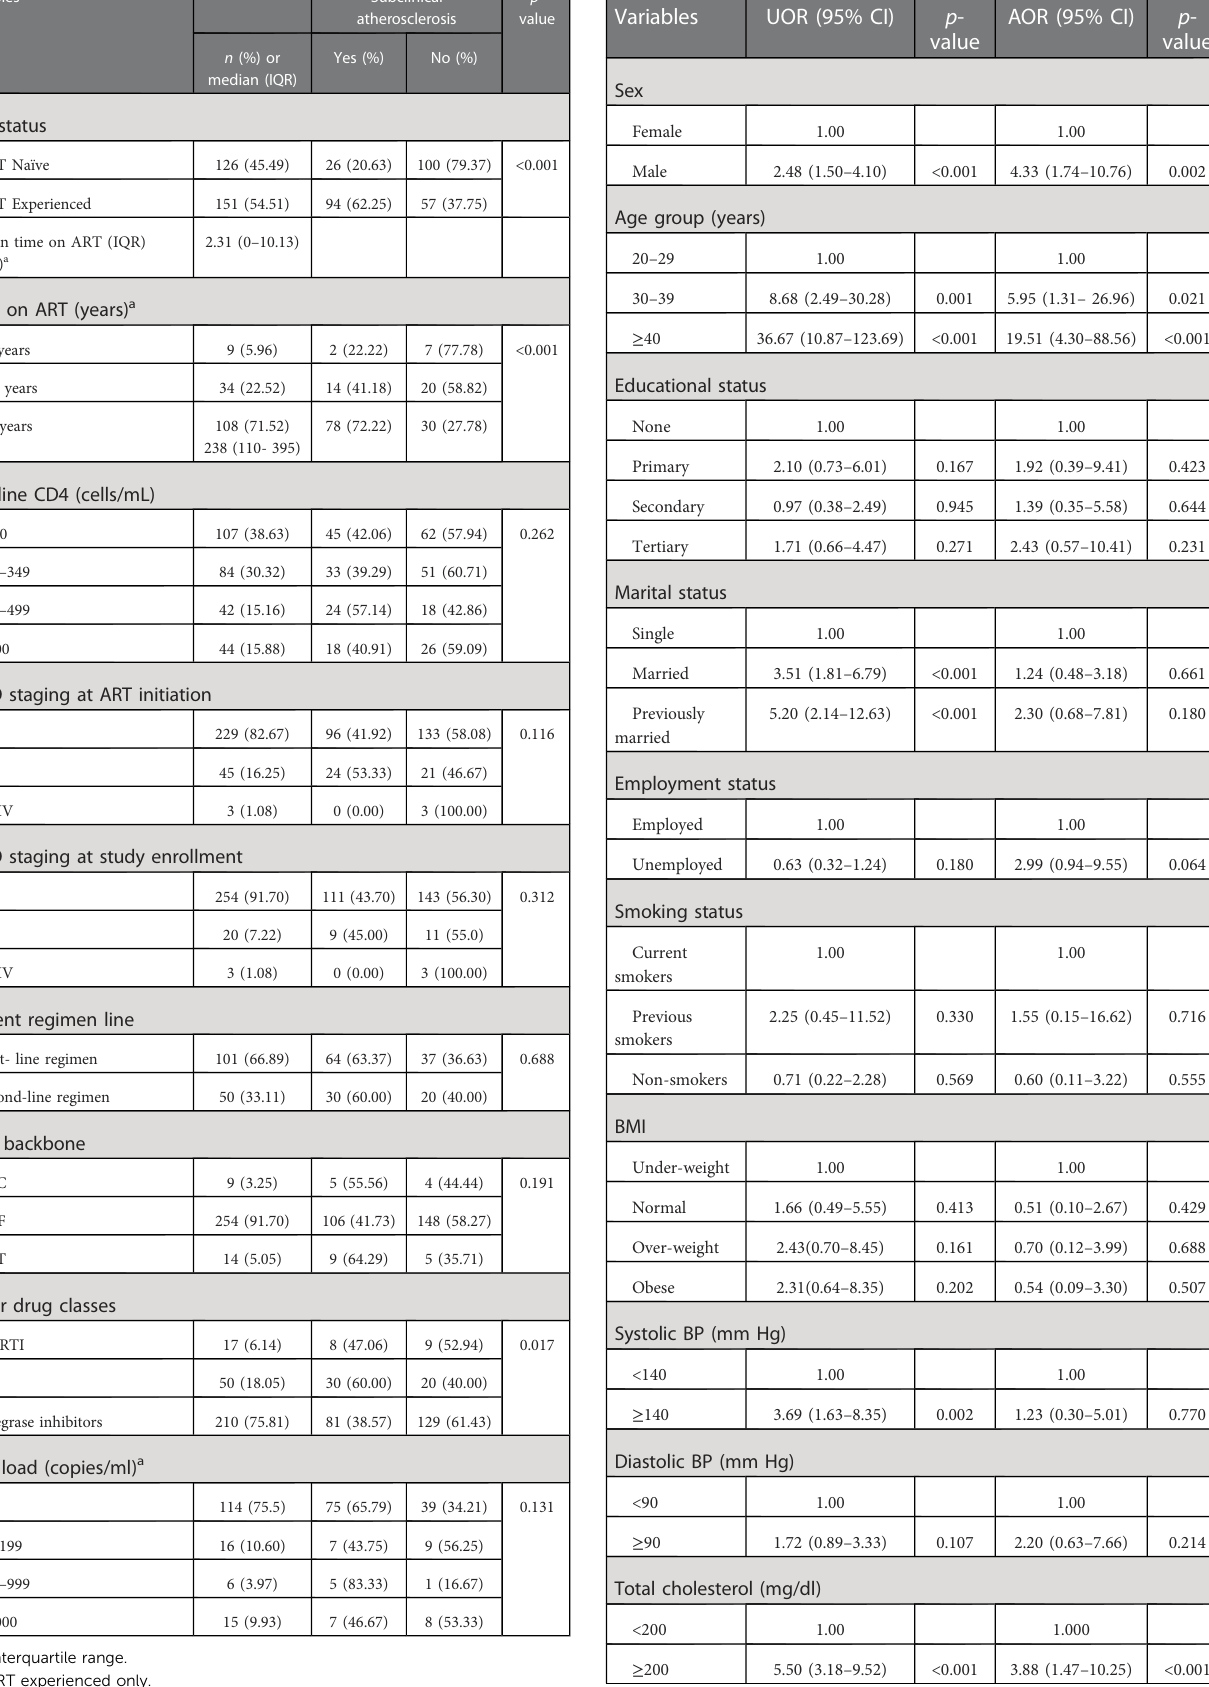
TABLE 3 HIV-related variables and associations with subclinical atherosclerosis. Variables